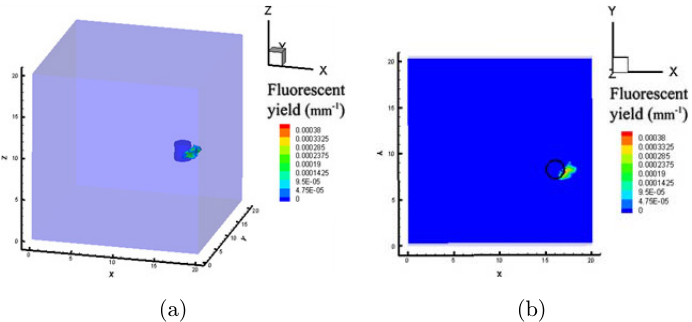
Fig. 8. Phantom results. (a) The isosurface view of the reconstruction with top 80% of the maximum value. The blue cylinder represents the real Cy5.5 solution, while the green zone is the reconstructed target. (b) The transverse view of the reconstruction is on the z ¼ 9 : 5-mm plane. The black circle represents the real